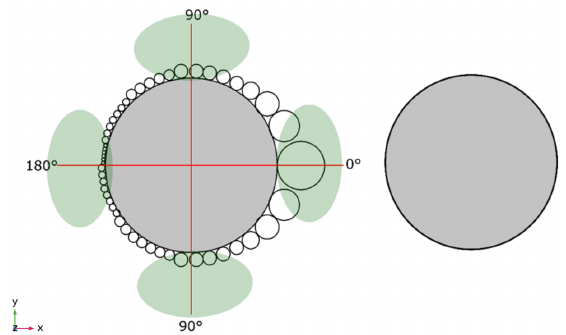
Figure 4. Description of bubble measurement technique.